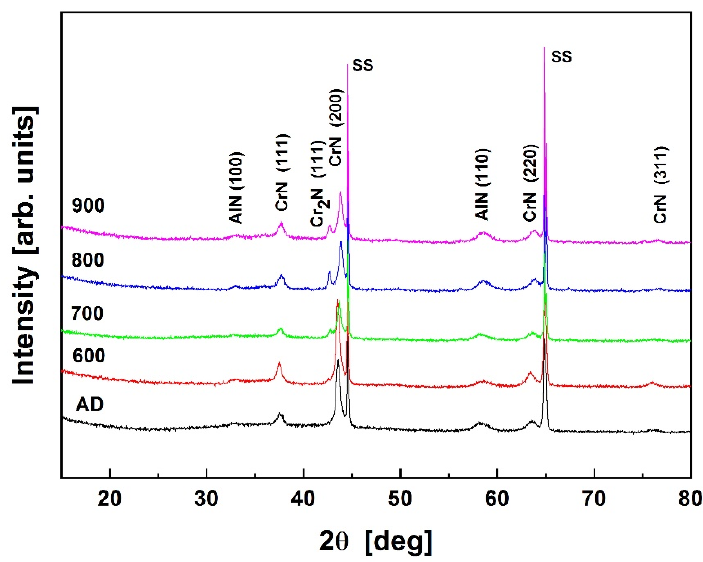
Figure 7. XRD pattern of as-deposited and treated at different temperatures. CrAlSiN-AlSiN coat- ing.